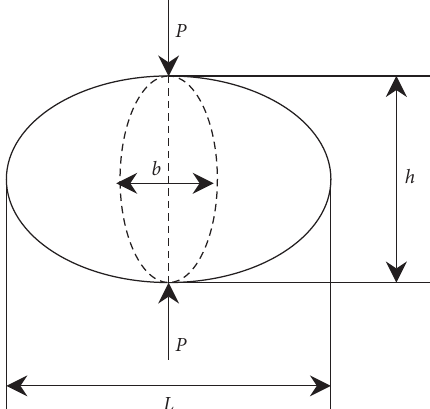
Figure 3: Sample loading diagram.